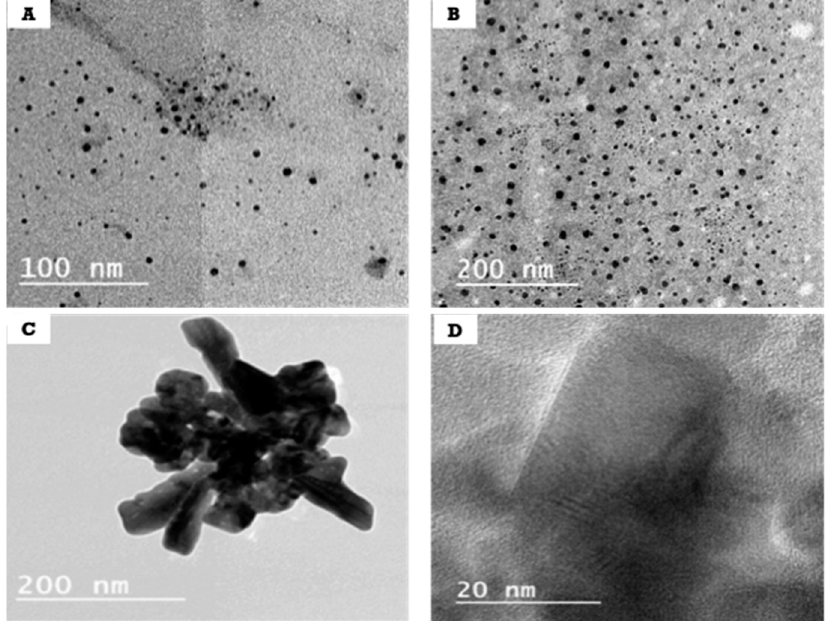
Figure 3. TEM images of ( A ) ZnONPs-1, ( B ) ZnONPs-2 and ( C ) ZnONPs-3, and ( D ) high-resolution TEM image of ZnONPs-2.